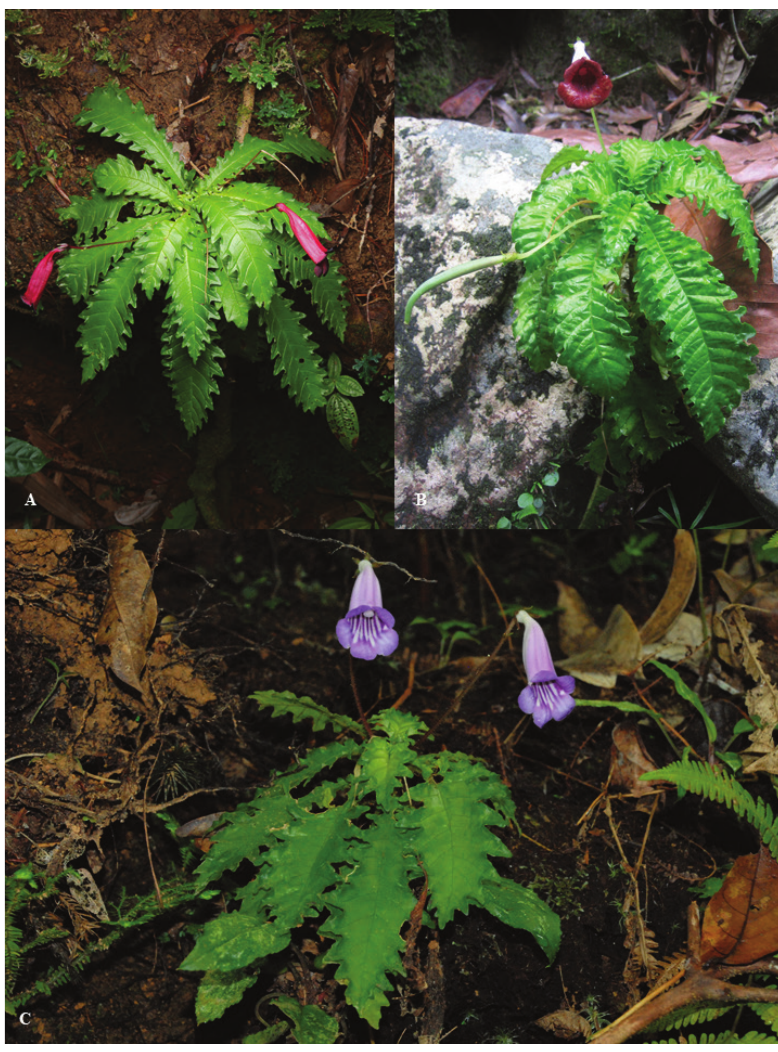
Figure 4. Comparison of resembles species A Ridleyandra merohmerea B Ridleyandra iminii C Ridleyandra morganii (Photo by A Zaharil D B – C Siti-Munirah